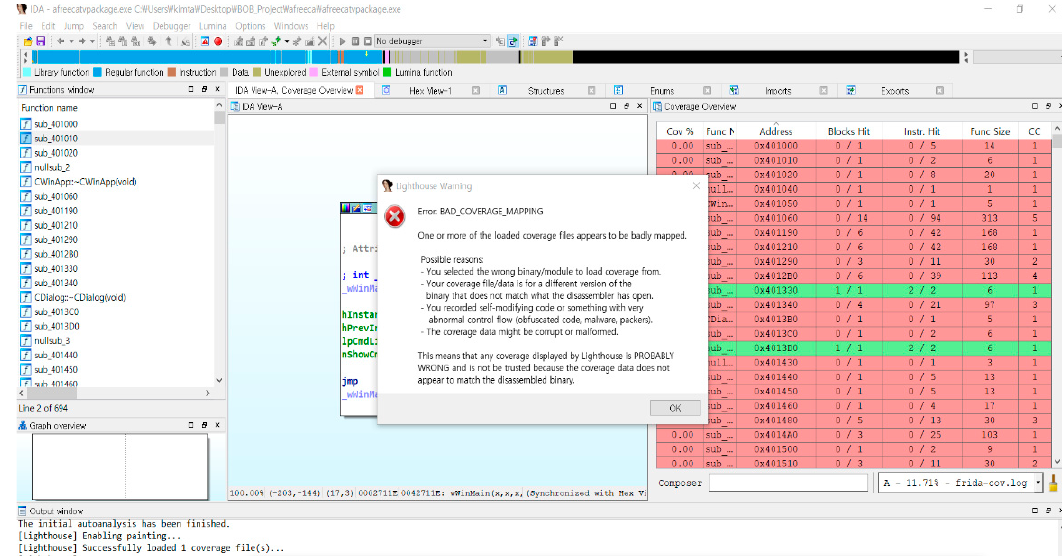
Figure A1. Example of DoS attack through video data tampering (picture distortion).